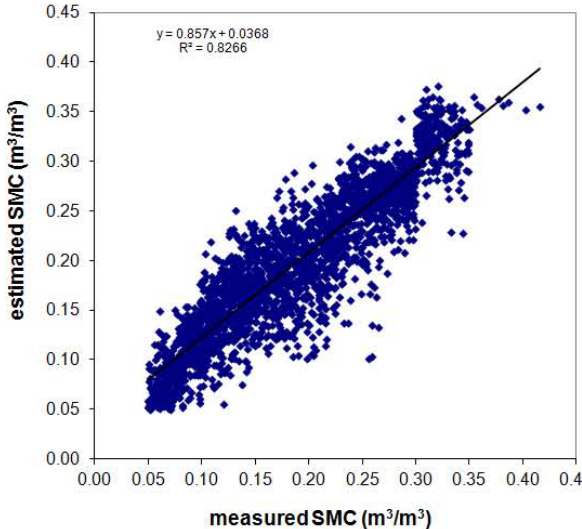
Fig. 7. SMC estimated by using the ANN algorithm as a function of SMC measured on ground for the part of Australian and Mongolian dataset not used for training.